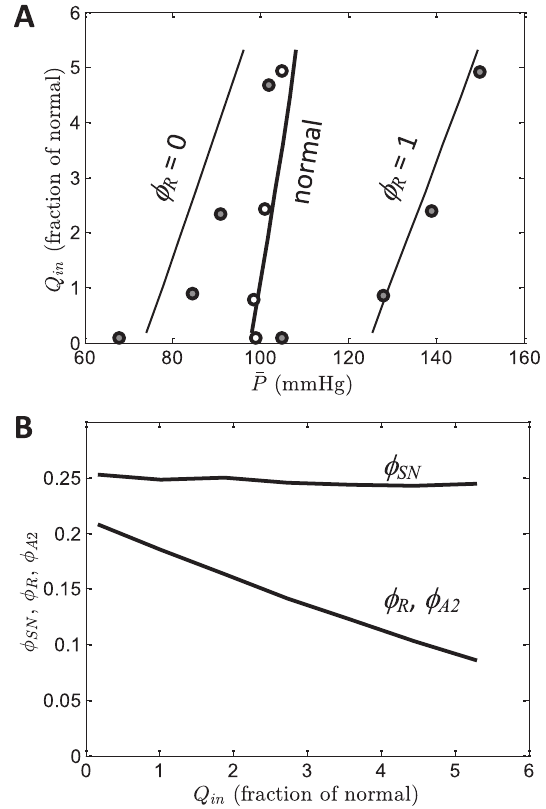
Figure 8. Renal function curves. A . Model predictions are compared to data on the steady-state relationship between mean arterial pressure and rate of volume infusion (equal to rate of urine output) for normal conditions, for angiotensin converting enzyme inhibition ( φ = 0), and for angiotensin II infusion ( φ = 1). Data are R R obtained from Hall et al . 17 , in which net salt output is reported under these three conditions. Rate of urine volume production is assumed proportional to rate of sodium excretion, and normalized to the – rate of urine production at baseline conditions ( P = 100 mmHg) for the normal case. B . Model prediction for steady-state renin and angiotensin II activities ( φ and φ ) and sympathetic tone ( φ ) are R A2 SN plotted as functions of Q for the normal case (without φ in R